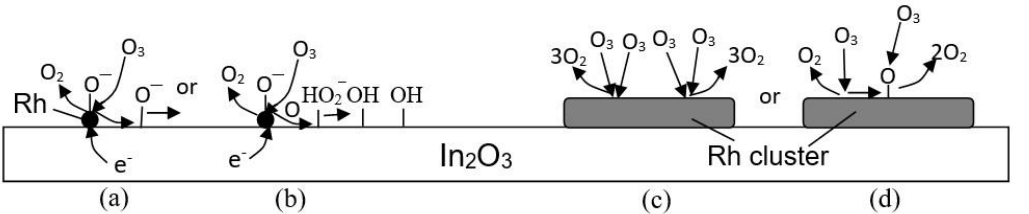
Figure 3. Schematic representation of the processes occurring on the surface of Rh/In 2 O 3 during ozone detection. ( a , b )— processes occurring on atomic rhodium, ( c , d )—processes on Rh clusters.